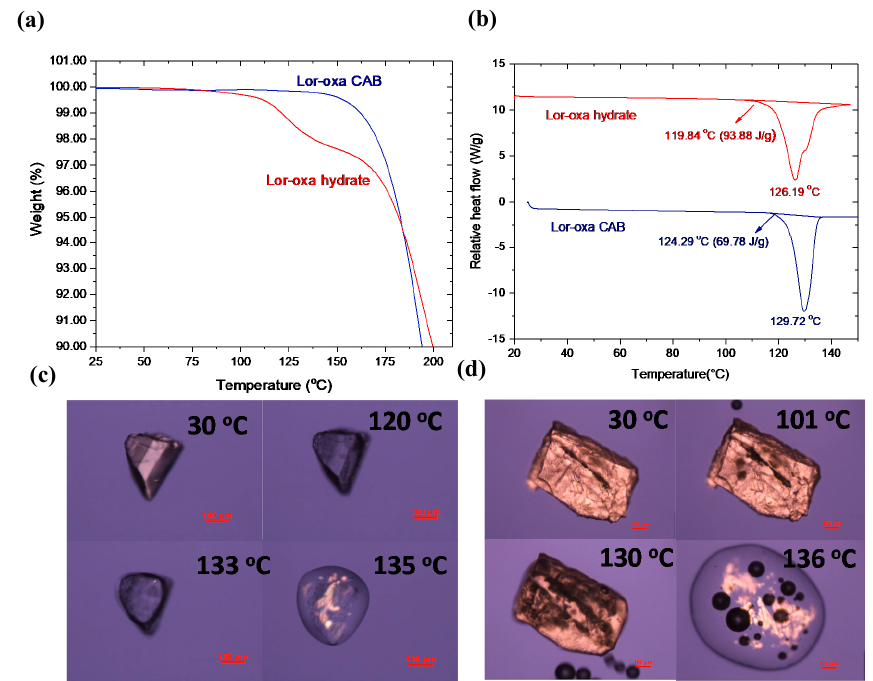
Figure 5. Thermal analyses of Lor-Oxa CAB and Lor-Oxa hydrate: ( a ) thermogravimetric analysis (TGA), ( b ) differential scanning calorimetry (DSC), ( c ) hot-stage microscopy (HSM) snapshots of Lor-Oxa CAB, and ( d ) HSM snapshots of Lor-Oxa hydrate.